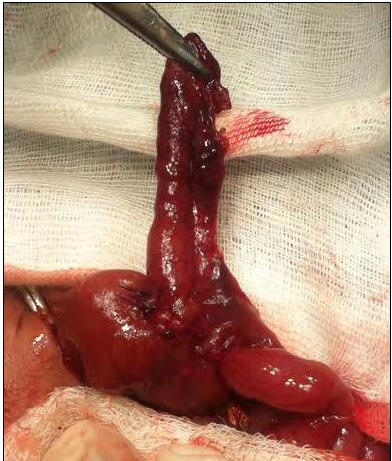
Figure 3: Showing the mesenteric conduit has been used to restore bowel continuity with the distal part of bowel atresia. The antimesenteric part is ready to bring out as enterostomy. The distal dusky portion will be excised leaving behind only 2-3cm of